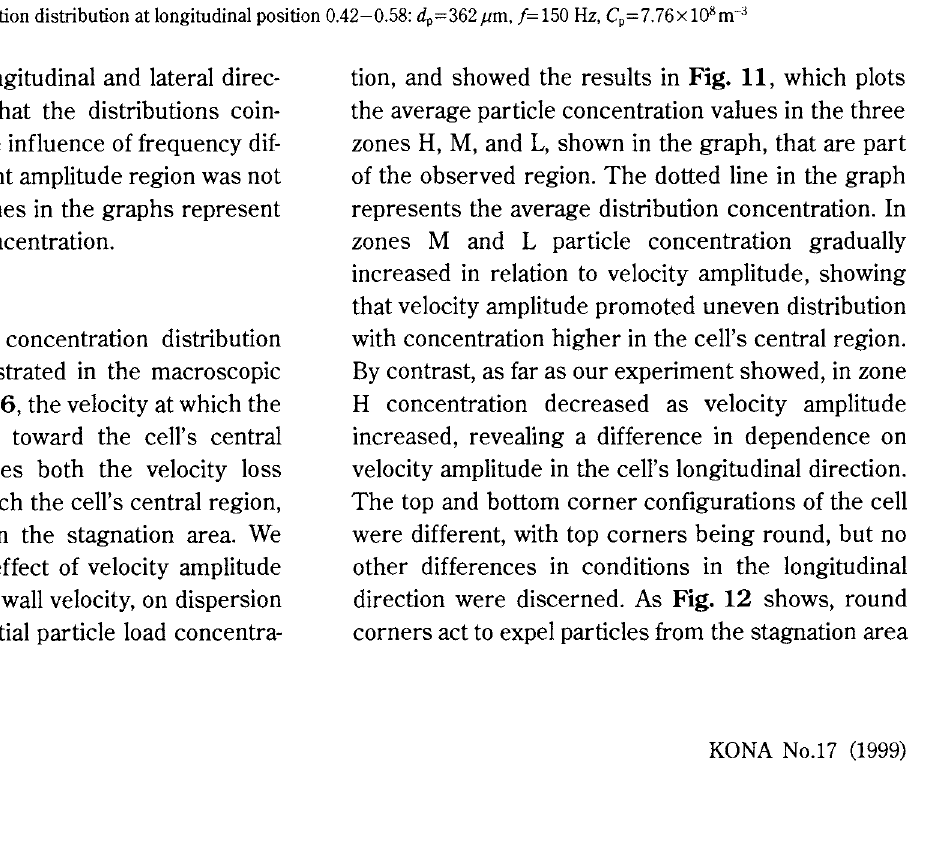
Fig. 8 Effect of displacement amplitude Ad (a) on longitudinal particle concentration distribution at lateral position 0.38-0.63, (b) on lateral particle concentration distribution at longitudinal position 0.42-0.58: dp=362 ,urn. f= 150 Hz, Cp= 7. 76 x 10 8 m-